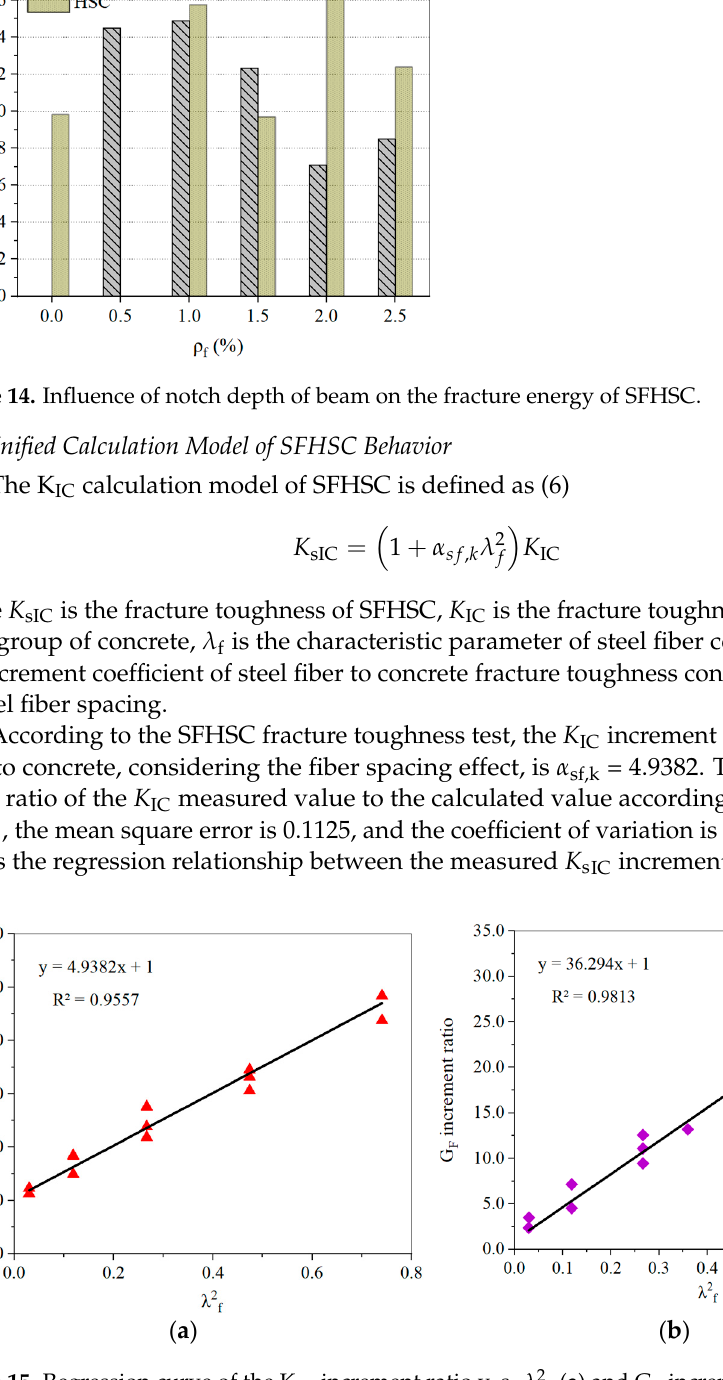
Figure 15. Regression curve of the K IC increment ratio v. s. λ 2f ( a ) and G F increment ratio v ( b